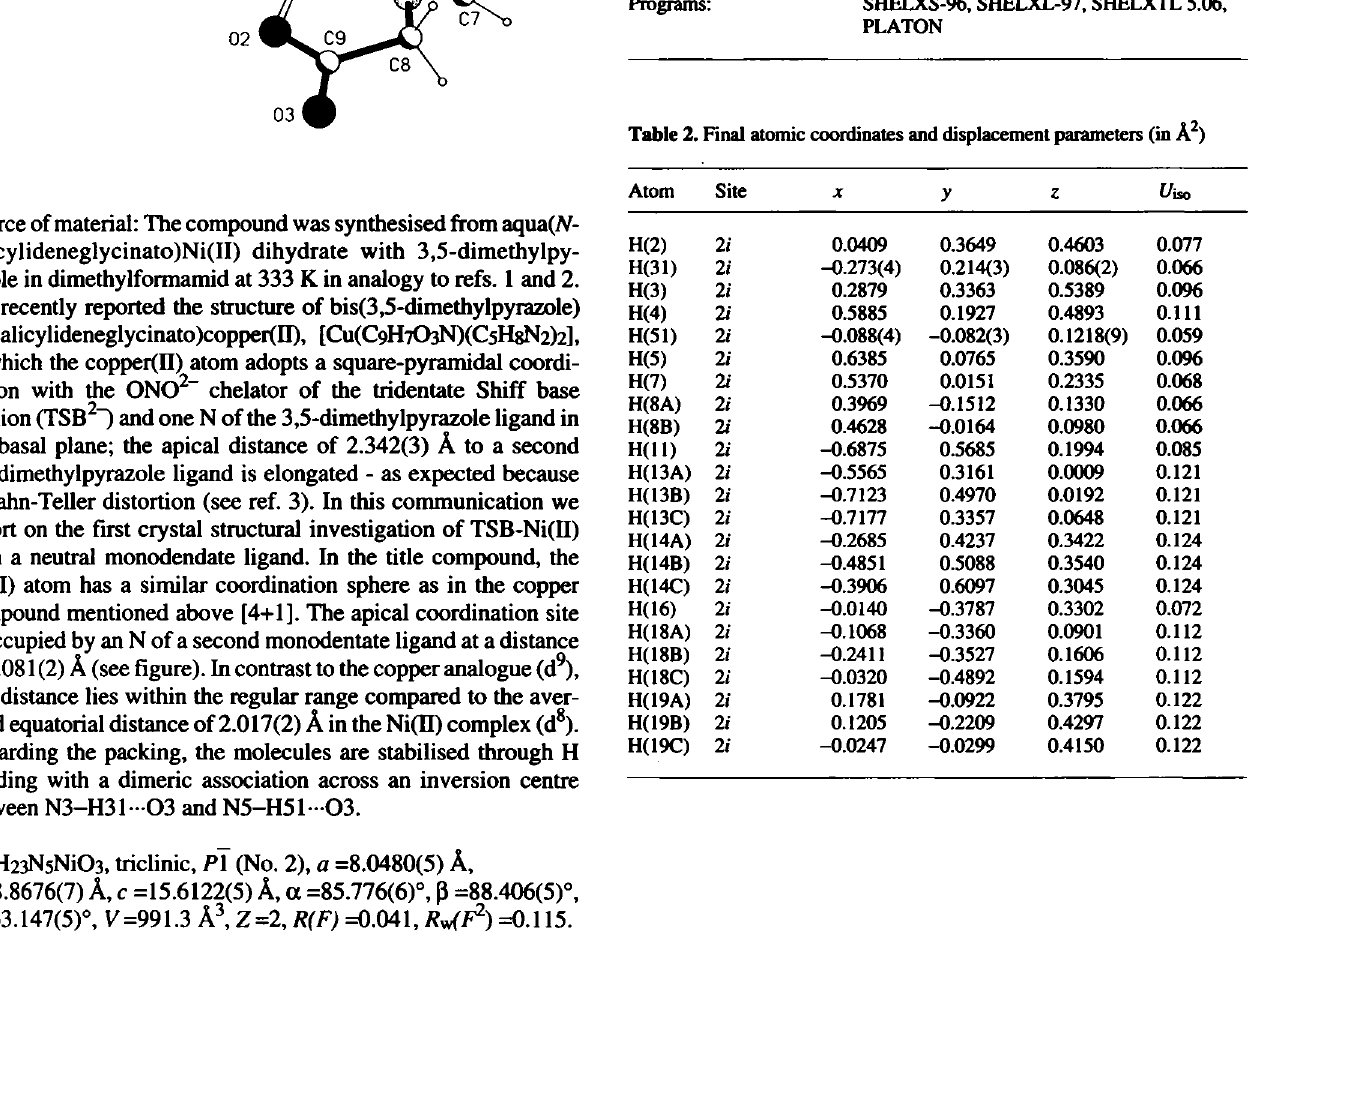
Table 1. Parameters used for the X-ray data collection